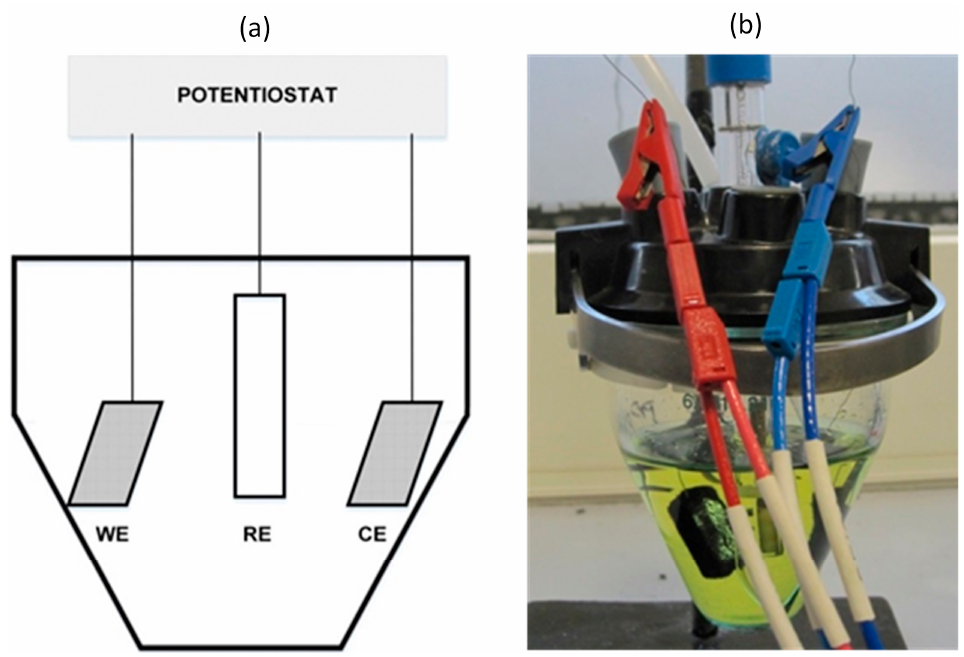
Figure 3. ( a ) Cell diagram (WE: working electrode; RE: reference electrode; CE: counter electrode) and ( b ) cell assembly.